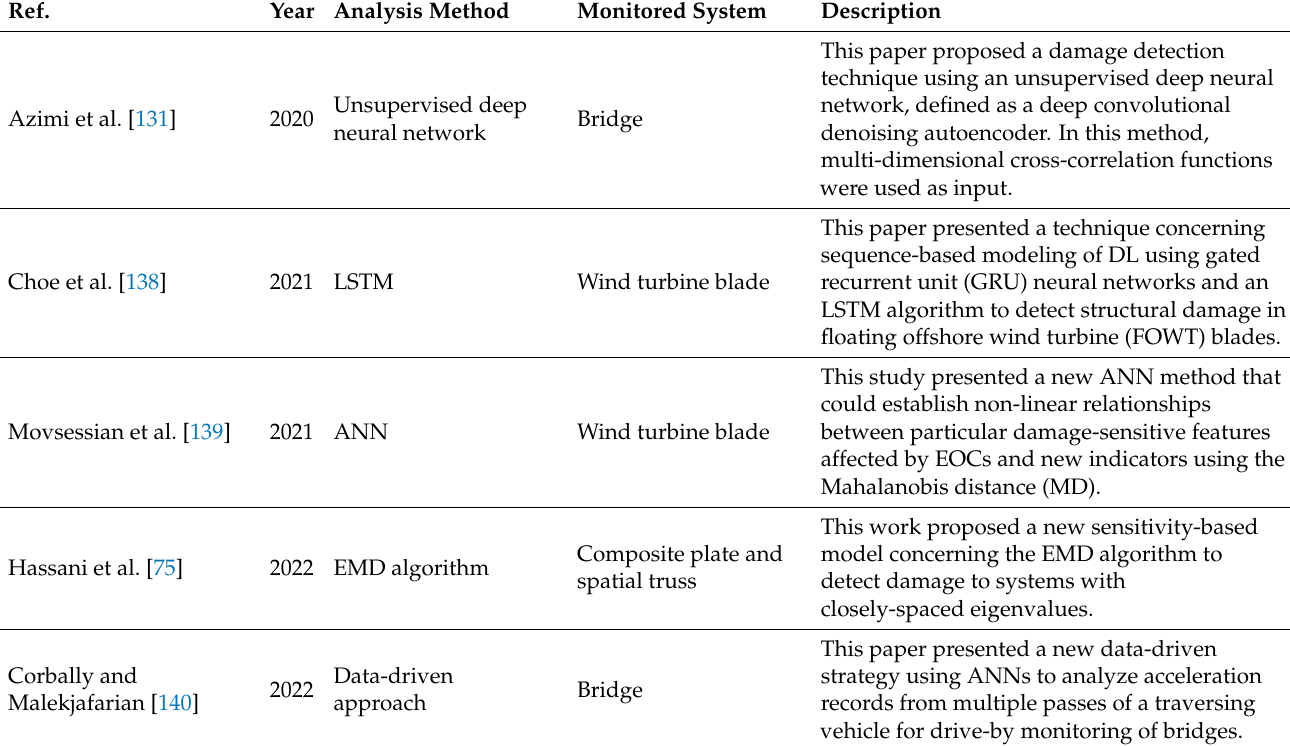
Table 10. Recent papers presenting new data analysis methods for SHM.